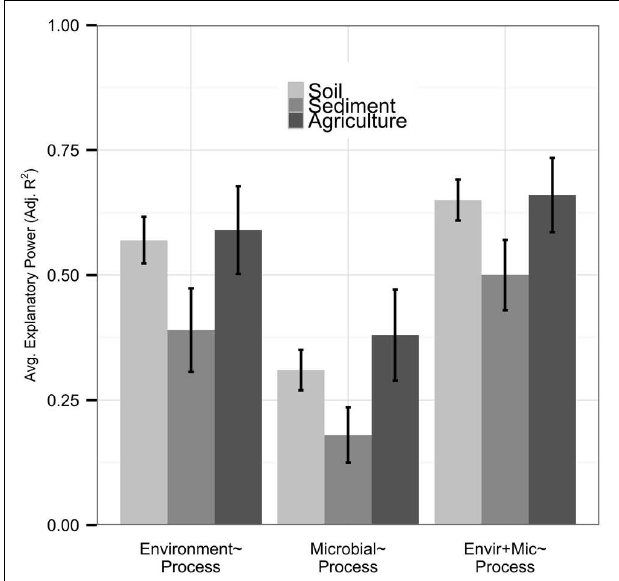
FIGURE 3 | Rates of respiration ( n = 26) were well-explained by all predictor sets relative to the full dataset. In this figure, we present microbial biomass in addition to microbial community structure, with standard errors represented as error bars. Microbial community structure and biomass independently had low explanatory power compared to environmental variables; however, they were largely uncorrelated with each other and provided greater model improvement when added to environmental variables in conjunction than when added independently.